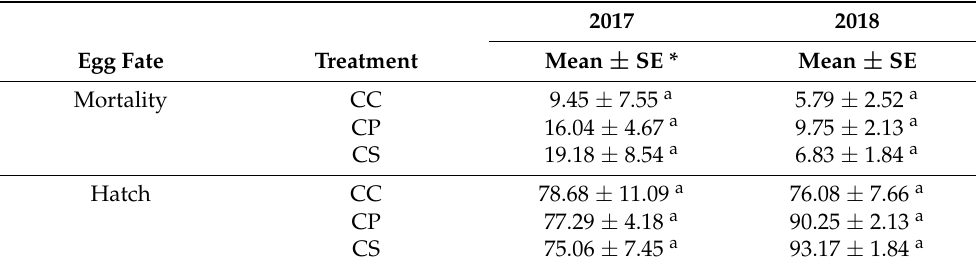
Table 6. Percentage of Kudzu bug egg mortality due to predation and unknown factors, and proportion of hatched individuals in soybean during 2017 and 2018, at one field site, Beltsville [Central Maryland (CM)], across three post-harvest treatments following corn harvest. For the three treatments, CC denotes cover crop planted in corn residue/stubble; CP represents chisel plowed (conventional tillage) plot; and CS (corn stubble) no action.